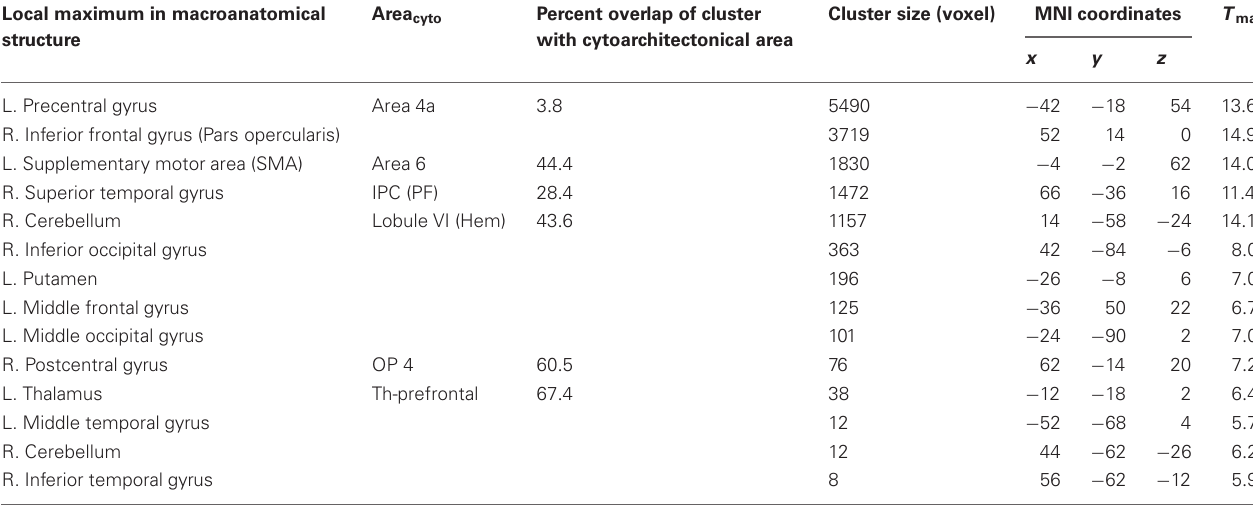
Table 1 | Macroanatomical structure, cytoarchitectonical area (Area cyto ), percent overlap of cluster with cytoarchitectonical area, cluster size in voxel, MNI coordinates ( x , y , z ), and maximum T value ( T max ) of the local maxima for the functional localizer task compared to rest. Local maximum in macroanatomical structure